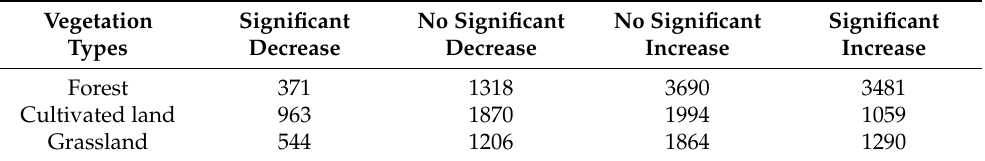
Table 7. Pixel numbers containing different trends in LOS of three vegetation types of northeast China for 1982–2014 (5% significance